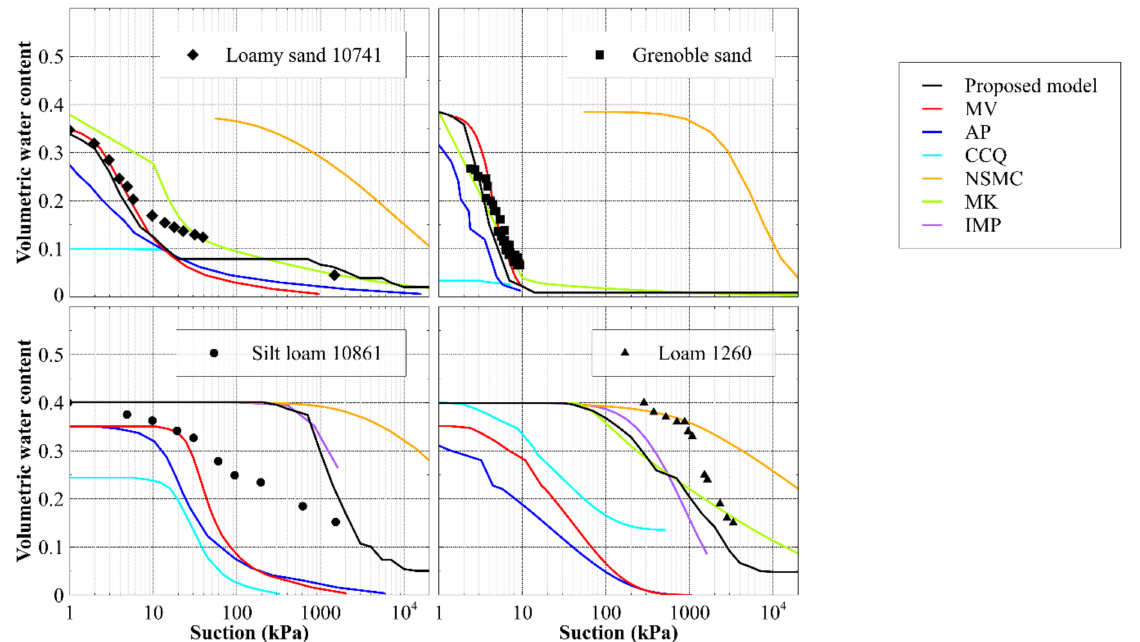
Figure 15. Water retention curve predictions for sand and loam materials from the literature. Predictions from the proposed model and various models from the literature are shown, with water retention curves expressed in terms of volumetric water content vs. suction. Appendix A provides each material’s relevant properties and GSD, and Appendix B states the model parameters used.